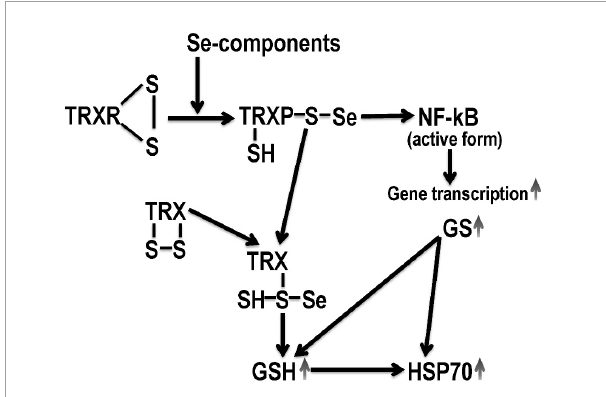
FIGURE3 Hypothetical mechanism of selenium derivatives